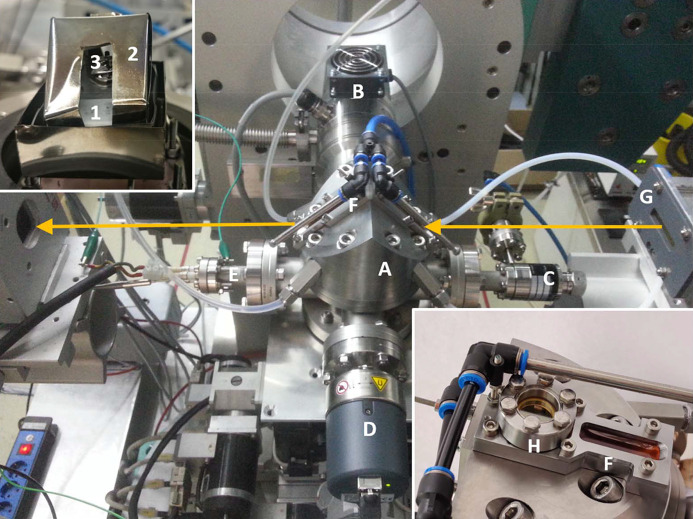
View of the realized cell for X-ray experiments at elevated temperatures mounted on the X-ray diffractometer of DELTA beamline 8. (A) Main body of the cell (dome), with (B) turbomolecular pump, (C) fine leak valve, (D) vacuum gauge, (E) electrical feedthrough for the connection of the heater, (F) air-cooled X-ray windows, (G) ionization chamber for the incident intensity measurements. In the upper inset, the interior of the cell is displayed after the removal of the dome A. The ceramic heating plate (1) with the heat shield (2) and a mounted sample (3) is visible. The X-ray pathway is indicated by orange arrows. In the lower inset, a detailed view of the air-cooled windows is depicted, and in particular the IR-transparent ZnSe-window (H) can be identified.